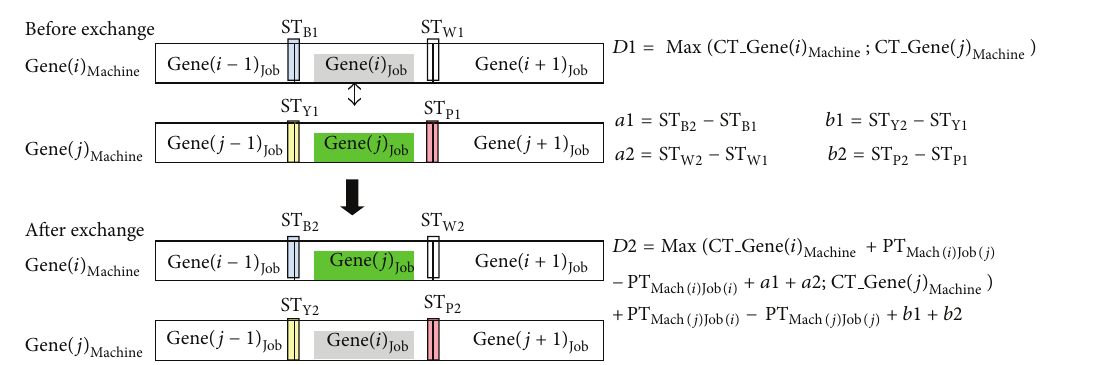
Figure 7: Intramachine exchange (exchange of Gene (𝑖)